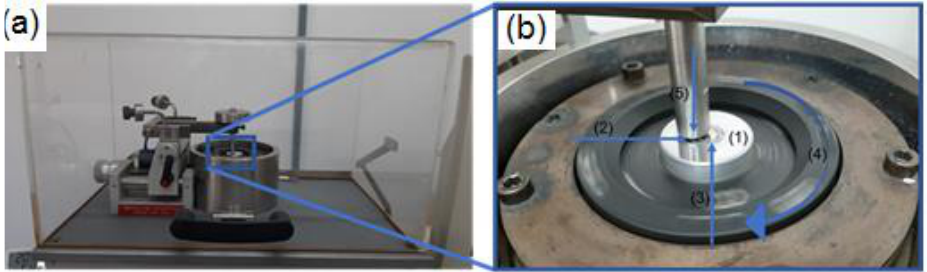
Figure 1. ( a )equipment for ball-on-disk testing; ( b ) detailed scheme of testing (1) sample, (2) ball, (3) wear path on sample (4) rotation sense of sample and (5) load. (3) wear path on sample (4) rotation sense of sample and (5) load.